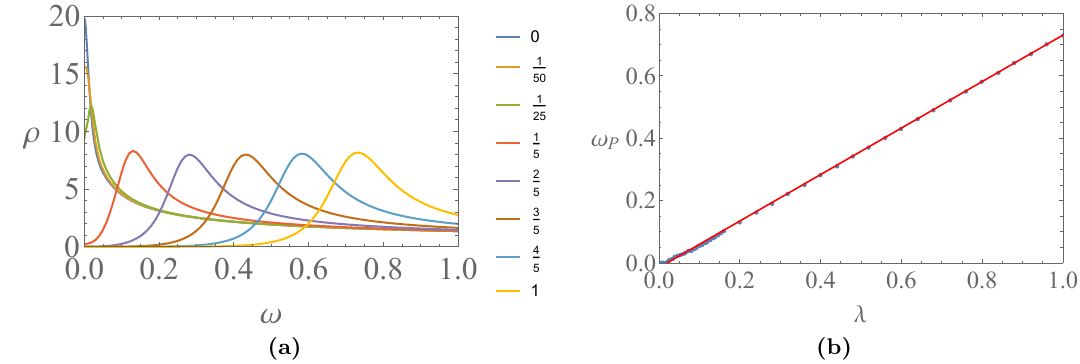
Figure 2 . (a) The holographic spectral function in alternative quantization at zero